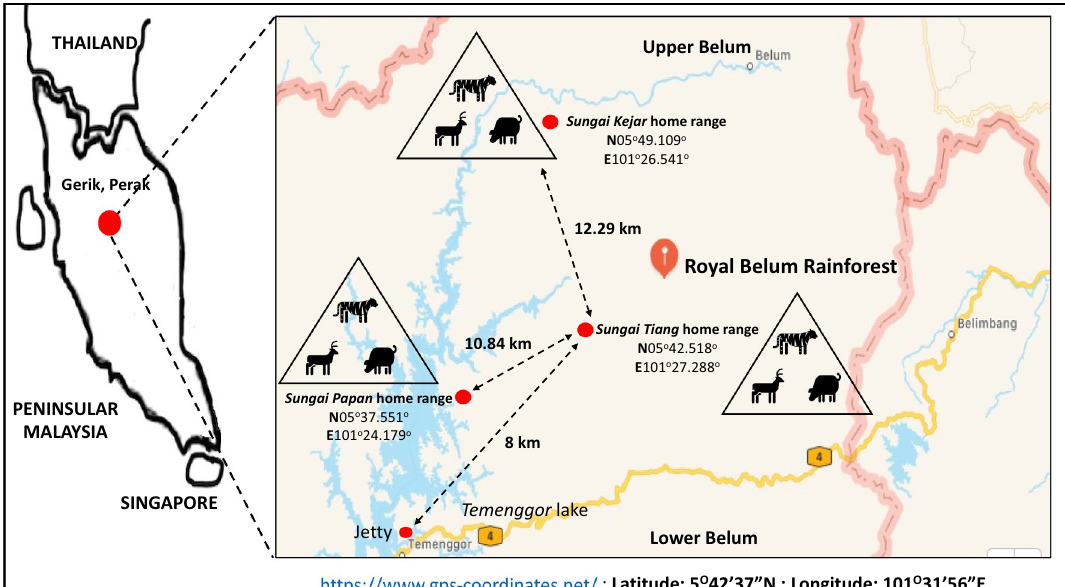
Figure 1. The location of the Royal Belum Rainforest, Peninsular Malaysia and the tracked home range of tigers around natural salt licks. Map details: (1) Peninsular Malaysia: The map was illustrated by the author of this manuscript. (2) Royal Belum Rainforest: Generated from GPS Coordinate (https:// www. gps- coord inates. net/); Latitude: 5°42 ′ 37 ″ N; Longitude: 101°31 ′ 56 ″